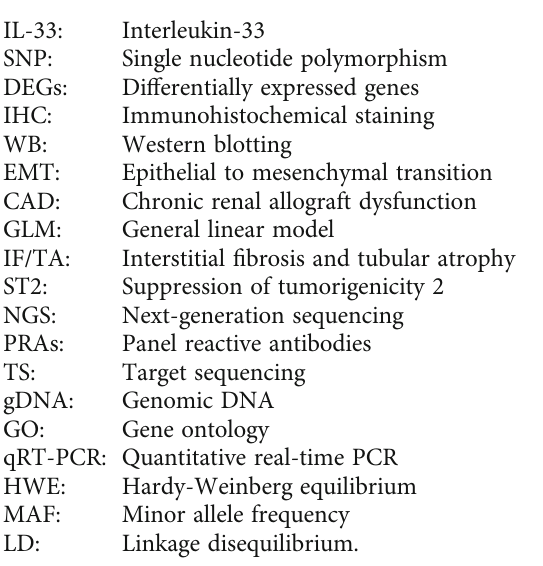
Supplementary 1 . Supplementary Table 1: detailed informa- tion of SNPs found in our study. Supplementary 2 . Supplementary Table 2: results of HWE analysis and MAF calculation for included SNPs in our study. Supplementary 3 . Supplementary Table 3: statistical results of fi ve inheritance models in non-signi fi cant tagger